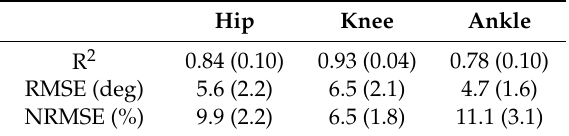
Table 4. Average error and accuracy of estimated angles (SD) in the inter-participant models among 10 participants. RMSE, root mean squared error; NRMSE, normalized root mean squared error.